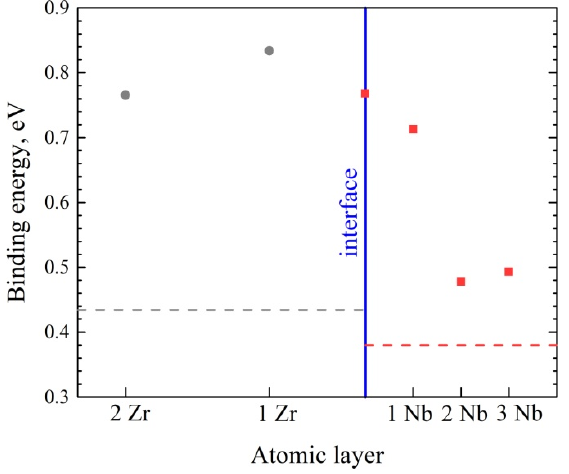
Figure 10. The dependence of the average value of hydrogen binding energy on the atomic layer number. The red and gray dotted lines indicate the average value of hydrogen binding energy in the Nb and Zr bulk, respectively.